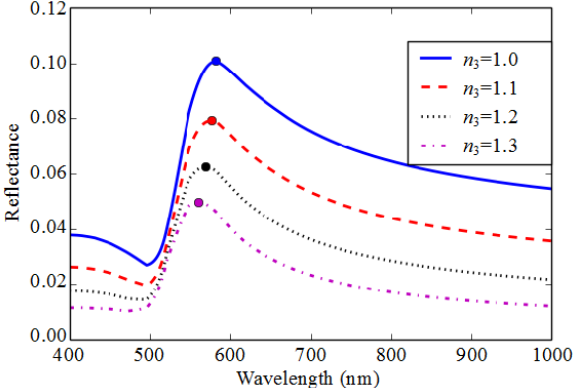
Fig. 2 Reflectance as the function of wavelength at different values of refractive index ( n 3 ) while the film thickness is kept fixed ( d = 80 nm). In this case, Au NP is used in the nanocomposite with filling factor f =